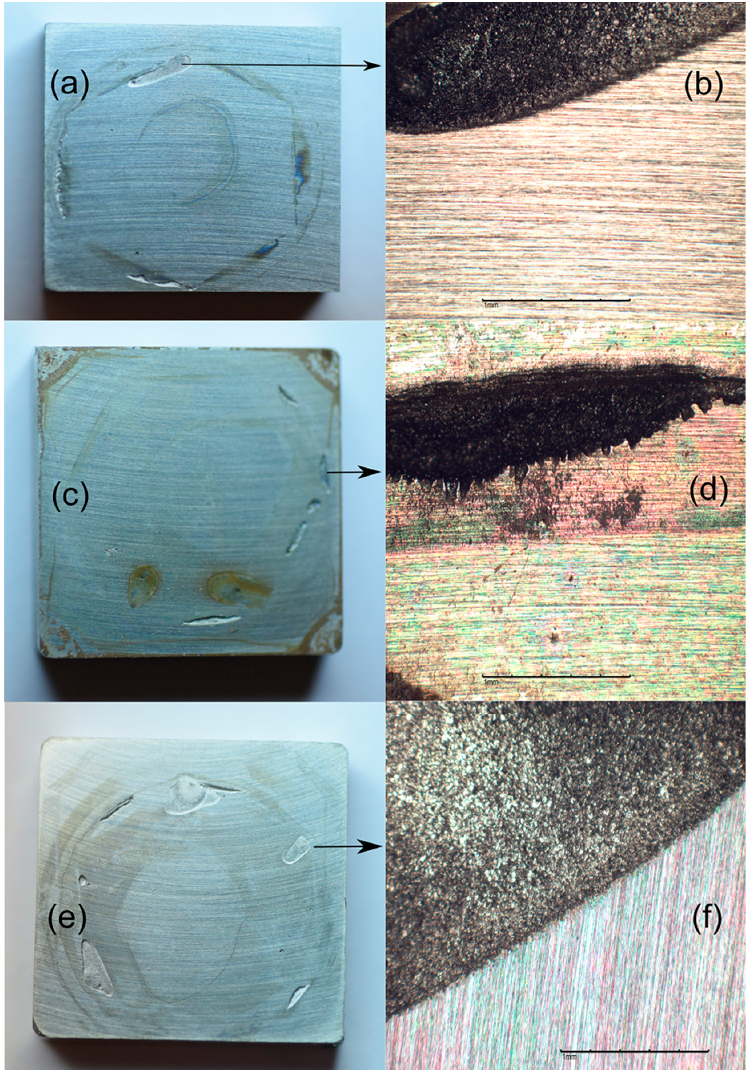
Figure A6. Digital photographs ( a , c , e ) and optical microscopy images ( b , d , f ) of crevices formed during CPP measurements on the surface of SS316L ( a ), spruce-coated ( b ), and beech-coated ( c ) lignin. Optical microscopy images were obtained from the spots marked with an arrow (scale bar: 100 µm).